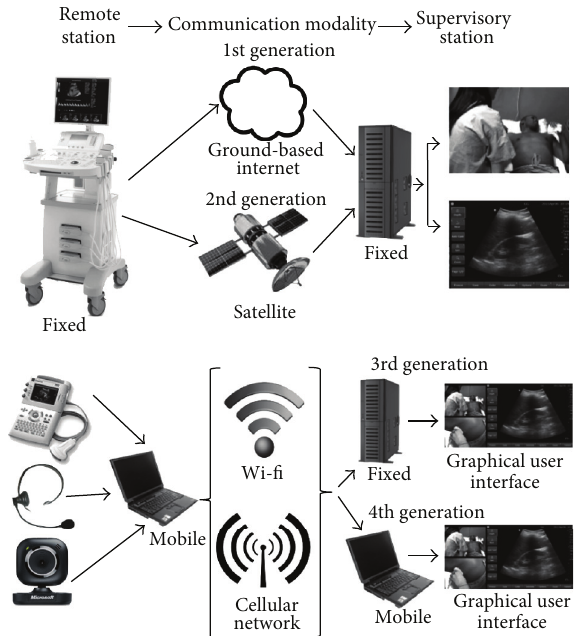
F 1: Schematic depiction and example of the system con- struction of the four generations of teleultrasound networks used to provide mentored tele-ultrasound